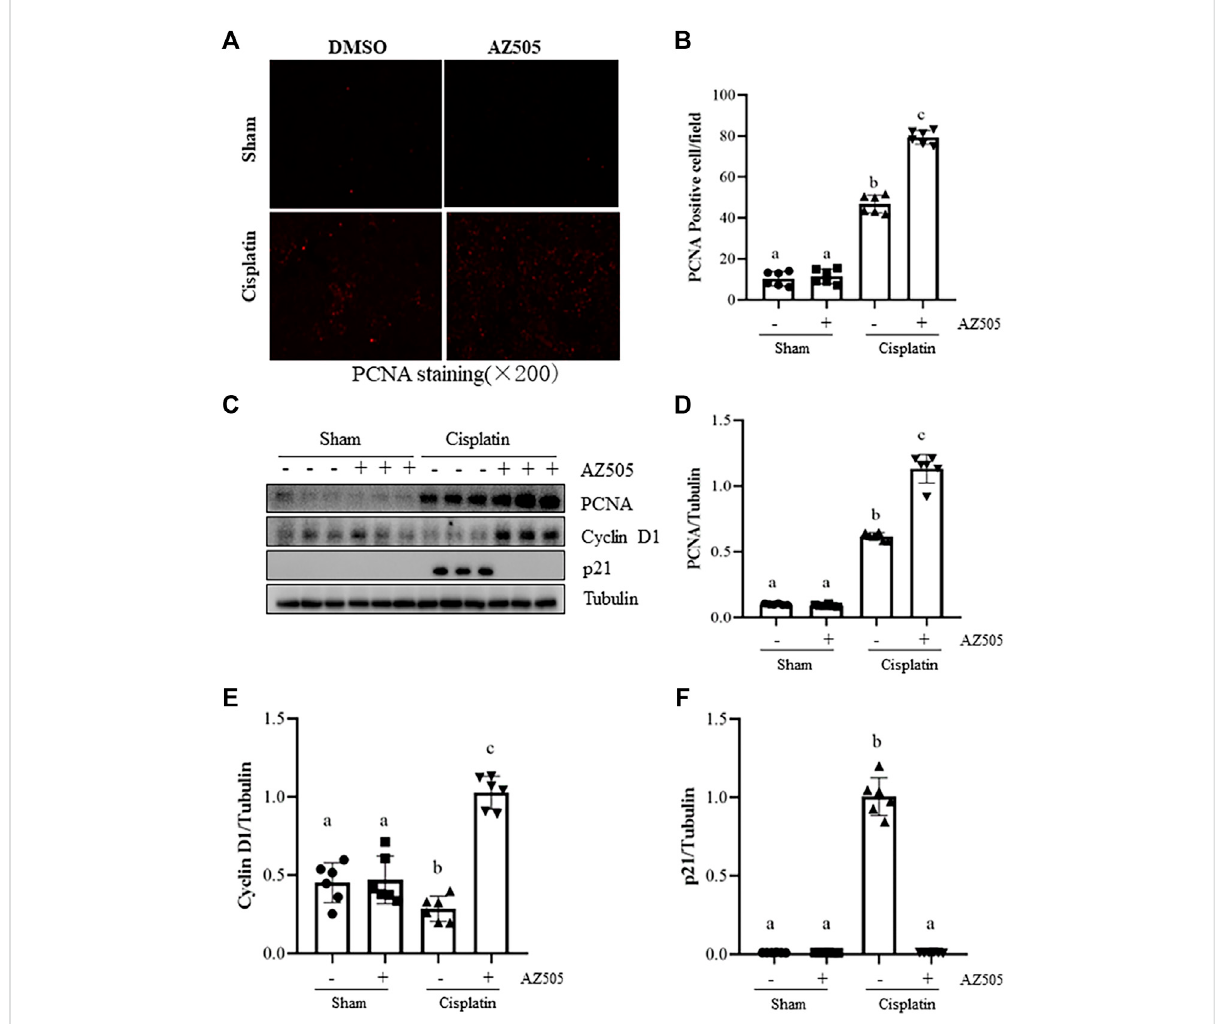
Administration of AZ505 promotes kidney tubular cell proliferation during the progression of cisplatin-induced AKI. (A) Photomicrographs illustrate immuno fl uorescencestaining for PCNA ofthekidney tissueswith orwithoutAZ505 treatment (×200). (B) The graph shows thepercentage of PCNA-positive areas (red) relative to the whole area from 10 random cortical fi elds (×200). (C) The kidney tissues were taken for immunoblot analysis of PCNA, cyclin D1, p21 and Tubulin as indicated. Representative immunoblots from 3 experiments are shown. (D – F) Expression levels of PCNA (D) , cyclin D1 (E) and p21 (F) were quanti fi ed by densitometry and normalized with β -Actin as indicated. Data are means ± S.E.M. ( n = 6). Means with different superscript letters are signi fi cantly different from one another ( p <